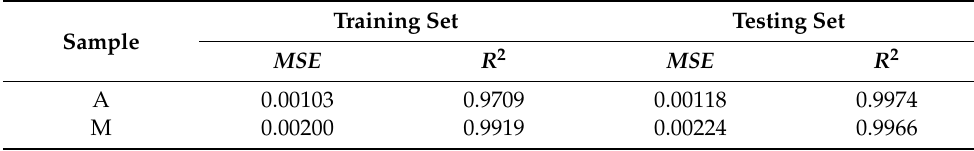
Table 10. MSE and R 2 of the training and testing